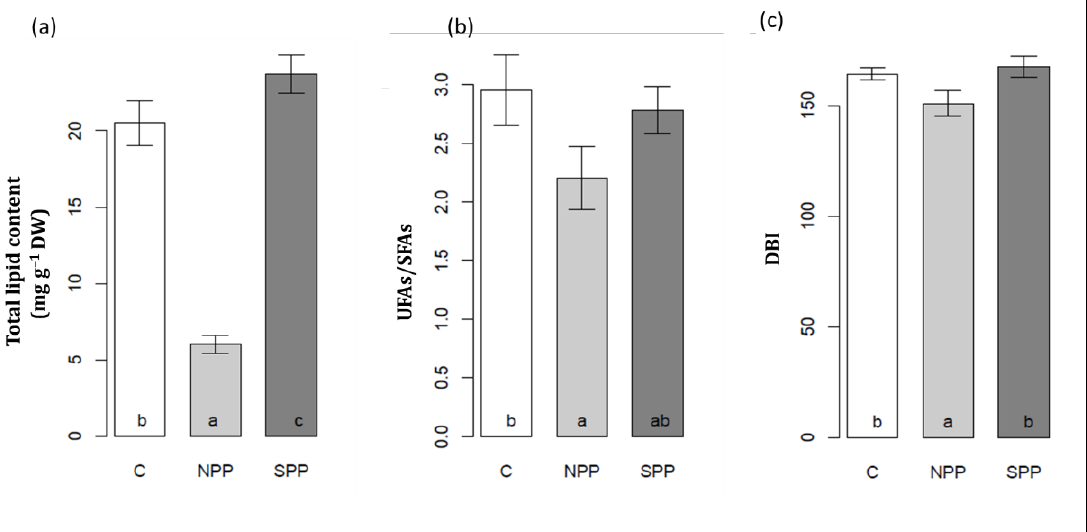
Figure 8. Changes in total lipid content ( a ), UFAs/SFAs × (unsaturated-to-saturated fatty acid ratio) ( b ) and in DBI × (double-bond index = R (unsaturated fatty acid × number of double bonds) ( c ) of olive leaves subjected to subsequent drought stress. Significant differences between the means (at p < 0.05, according to ANOVA) appear with different letters. Values are means ± standard error ( n = 6), where ‘ n ’ is the number of replicates for each group.